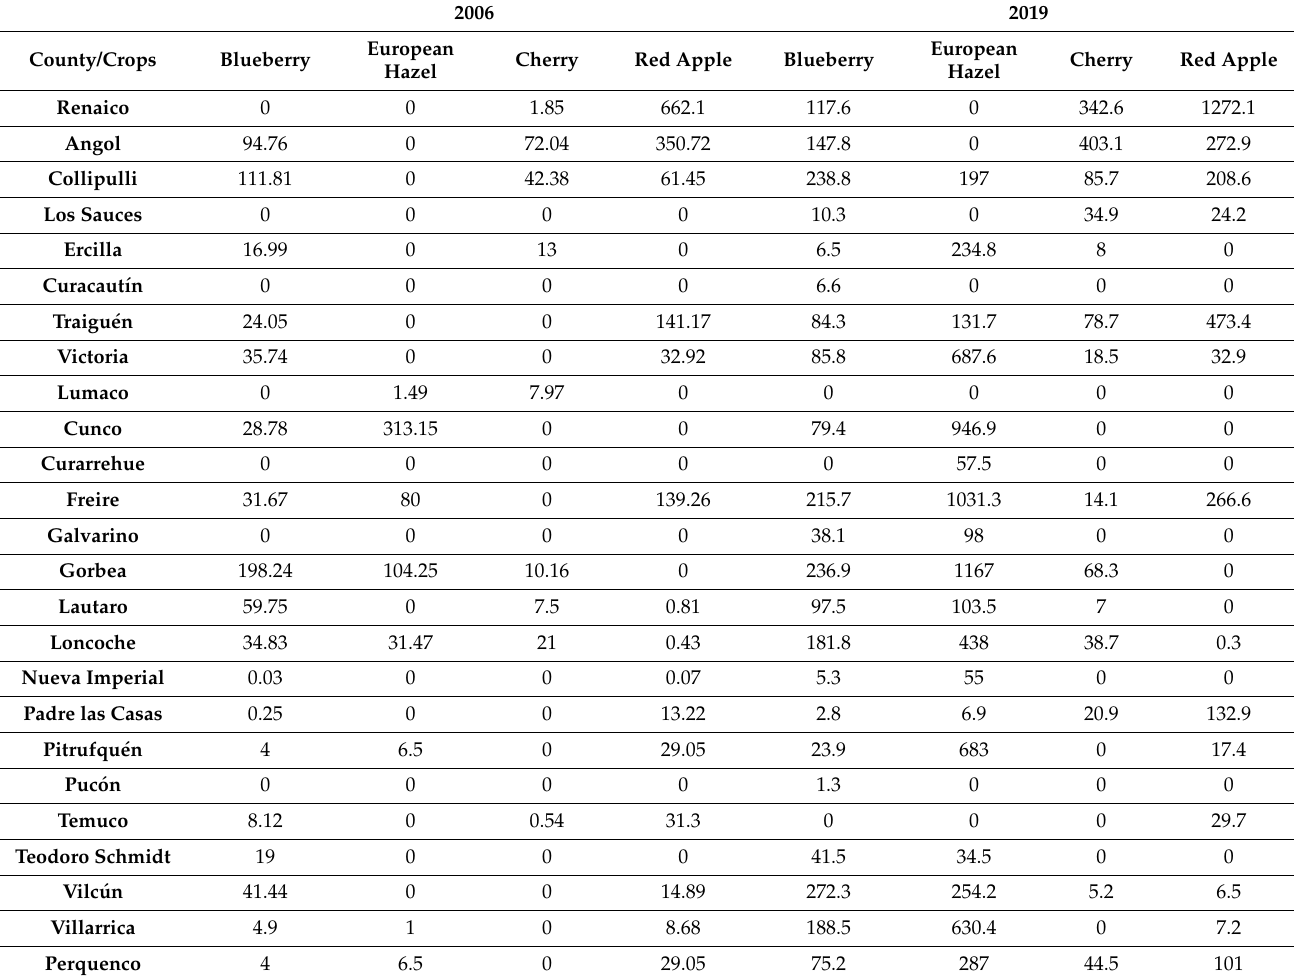
Table 2. Area (ha) type of fruit crops between the years 2006 and